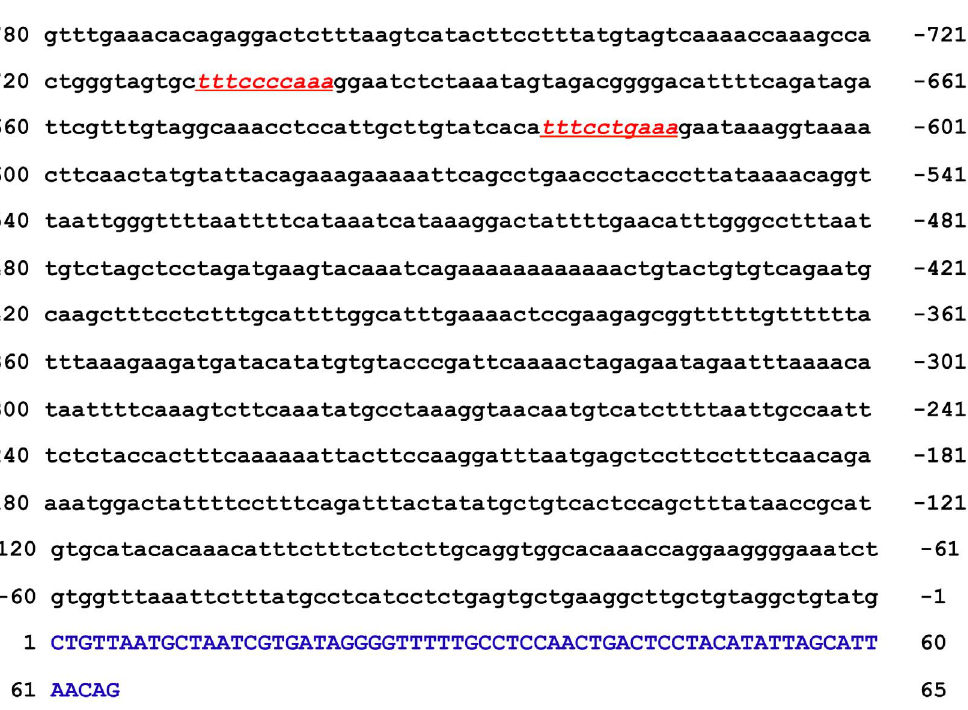
Figure 1. Sequence of the miR-155 gene promoter. Sequence analysis of the miR-155 promoter detected two putative STAT3 binding sites